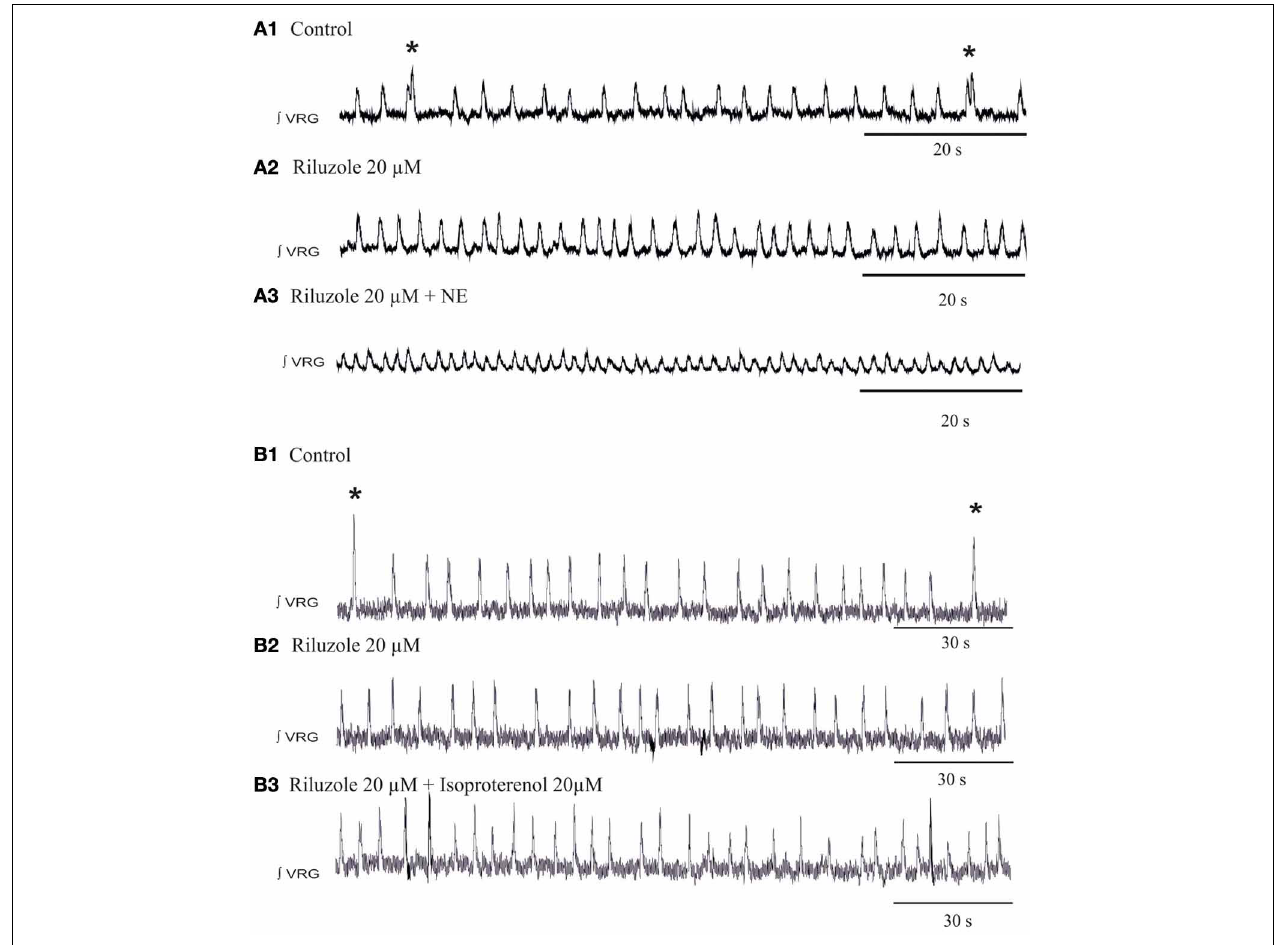
(cid:2) sigh activity. (B1) VRG activity recorded from a slice under control conditions. (B2) Application of riluzole (20 μ M) abolished the generation of sigh activity. (B3) Riluzole did block the effect of isoproterenol (20 μ M) on fictive sigh